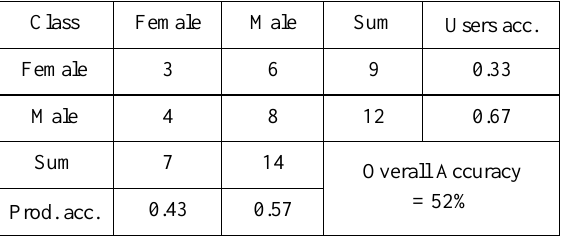
Table 3. Confusion matrices for random forest (RF) classification. Columns show ground truth and rows show classification